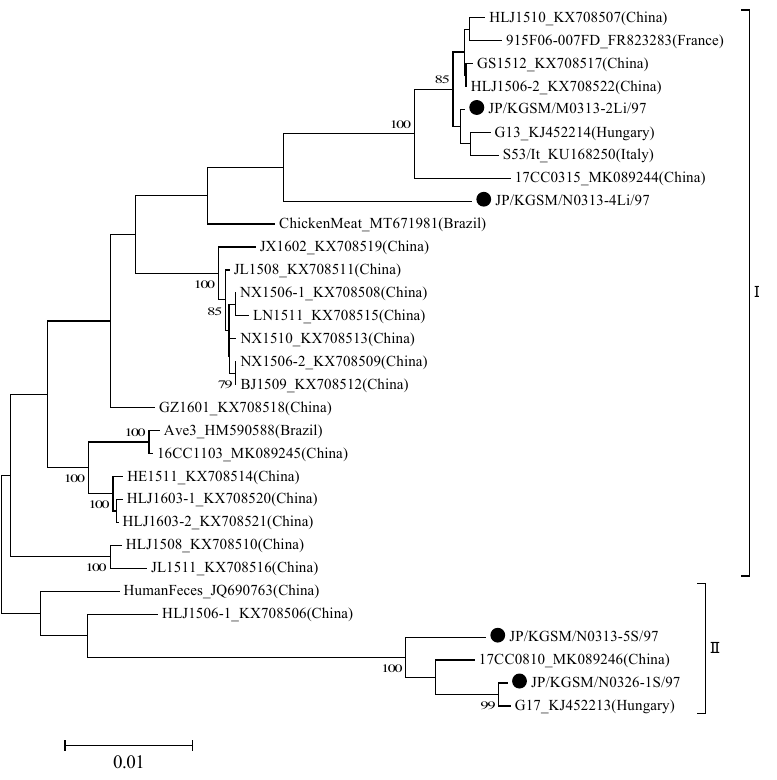
Figure 3. Phylogenetic trees based on the near-complete genome of GyVg1 strain G13 (GenBank accession no. KJ452214). Nucleotides 1–2335 were subjected to phylogenetic analysis. Subsequently, a tree was generated using the neighbor-joining method in MEGA 7 [17] with 1000 bootstrap replicates. All tools were run with default parameters unless otherwise specified. Then, horizontal distances were proportionally set to the minimum number of nucleotide differences required to join nodes and sequences. The Japanese GyVg1 strains are indicated by black circles. The genotypes were defined as described by Yao et al. [2].